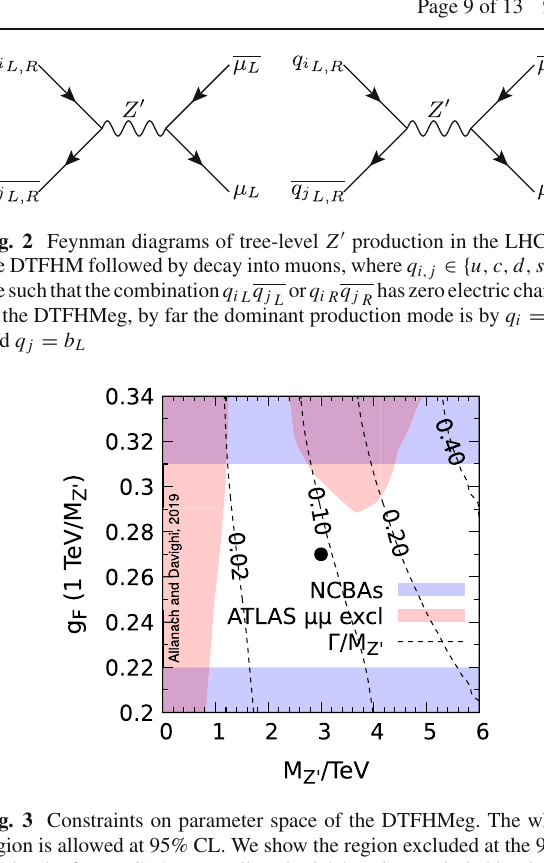
Fig. 3 Constraints on parameter space of the DTFHMeg. The white region is allowed at 95% CL. We show the region excluded at the 95% CL by the fit to NCBAs, as well as the 95% region excluded by the 13 TeV LHC 139 fb − 1 ATLAS search [70,71] for Z (cid:2) → μ + μ − (labelled by ‘ATLAS μμ excl’). Other constraints, such as from B s mixing, or lepton flavour universality of the Z boson’s coupling, are dealt with in the text and are less restrictive than those shown. The example point displayed in Table 3 is shown by the dot. Values of (cid:18)/ M Z (cid:2) label the dashed line